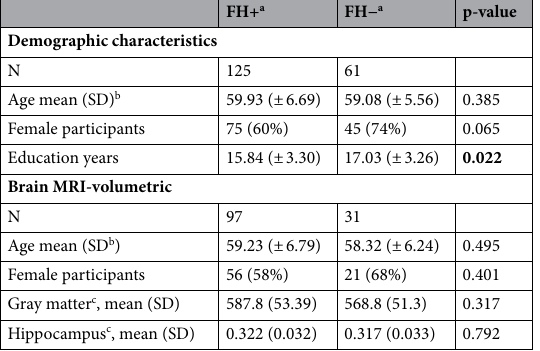
Table 1. Descriptive characteristics of the study cohort by Alzheimer disease (AD) family history. a FH = Family history of AD, b Age = age at pupilloperimetry testing, b SD = standard deviation; c mean of total volumes in cubic